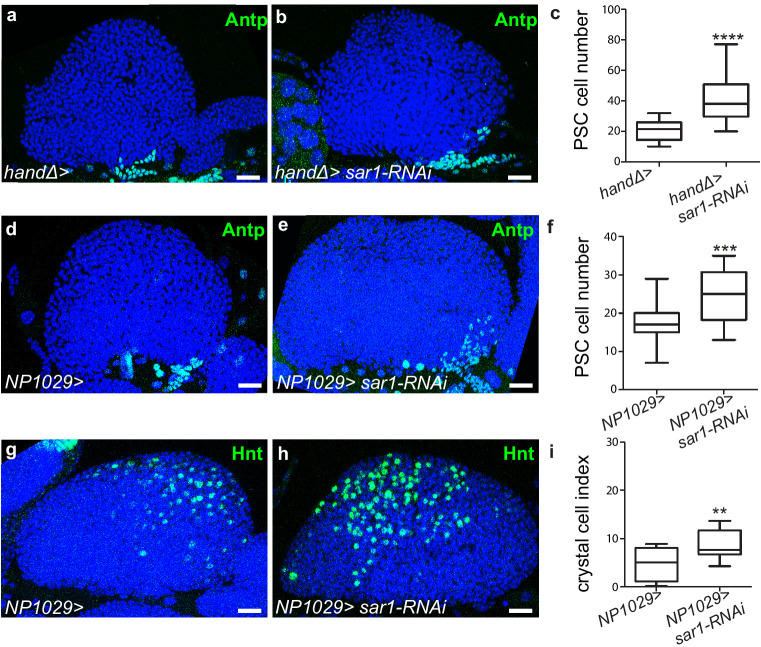
Knocking down sar1 in cardiac cells impairs crystal cell differentiation and increases PSC size.(a–b, d–e) PSC cells are labeled with Antp (green) antibody. An increase in PSC cell numbers is observed when sar1 is knocked down in cardiac cells using the handΔ driver (b) compared to the control (a). (c) Quantification of PSC cell numbers. (d–f) An increase in PSC cell number is observed when sar1 is decreased in cardiac cells using the NP1029 driver (e) compared to the control (d). (f) PSC cell numbers. (g, h) Crystal cells are labeled with Hnt (green) antibody. An increase in crystal cell number is observed when sar1 is knocked down in cardiac cells using NP1029, another cardiac cell driver (h) compared to the control (g). (i) Crystal cell index.Figure 4—figure supplement 1—source data 1.Quantification of Figure 4—figure supplement 1.